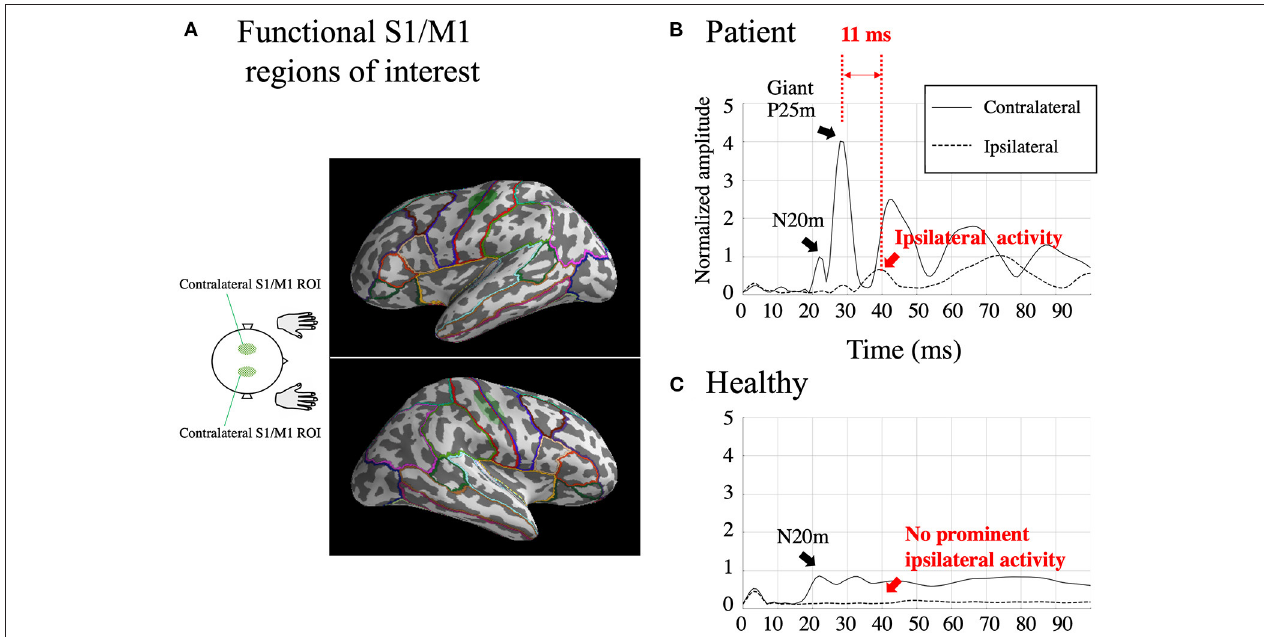
FIGURE 2 | Functional S1/M1 regions of interest (ROIs; green shaded areas) are shown in one subject [Patient 2; (A) ]. Borders of anatomical regions obtained from the Desikan-Killiany Atlas are shown in different colors. Estimated somatosensory-evoked field source activity within functional S1/M1 regions of interest in response to right median nerve stimulation from one patient who showed BCR [Patient 2; (B) ] and the grand-average of healthy controls (C) . Black lines: contralateral activity; dotted lines: ipsilateral activity. The figure shows a prominent contralateral giant P25m component. The ipsilateral activity, shown within 50ms, peaks 11ms later than the contralateral giant component. The amplitudes were individually normalized by contralateral N20m